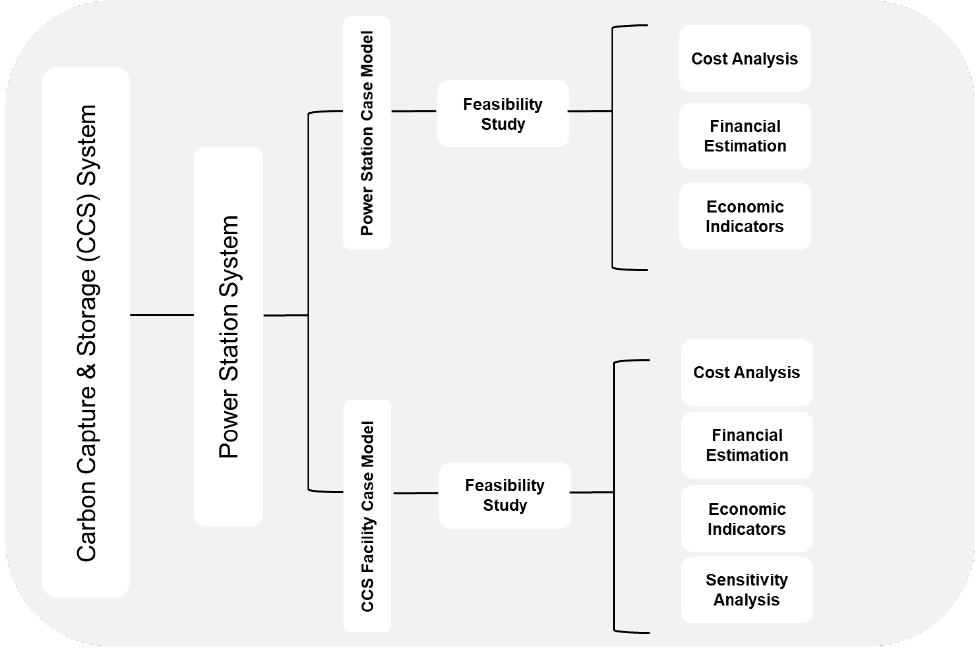
Figure 2. Methodology followed to conduct feasibility study based on techno-economic evaluation.